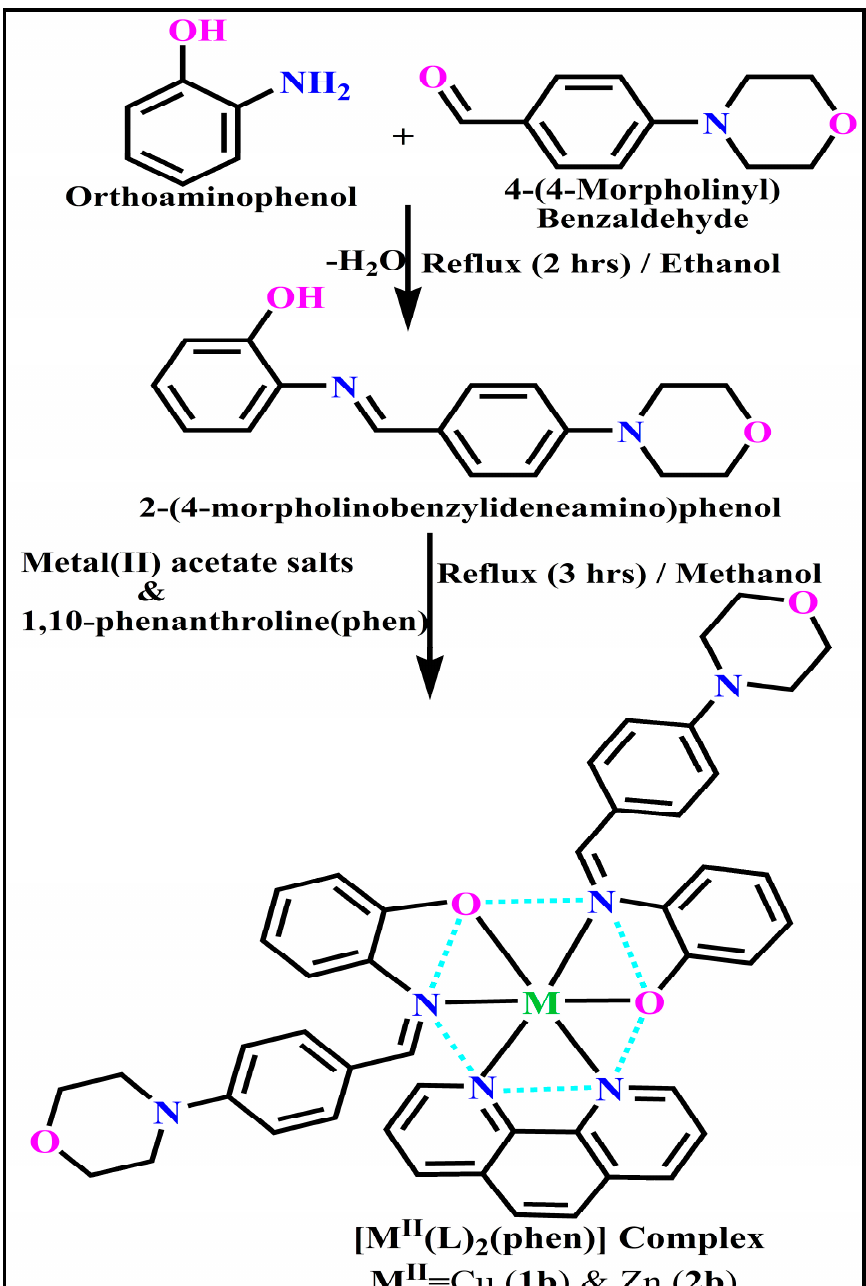
Figure 1. The proposed structure of complexes ( 1b – 2b ) [M II (L) 2 (phen)] .